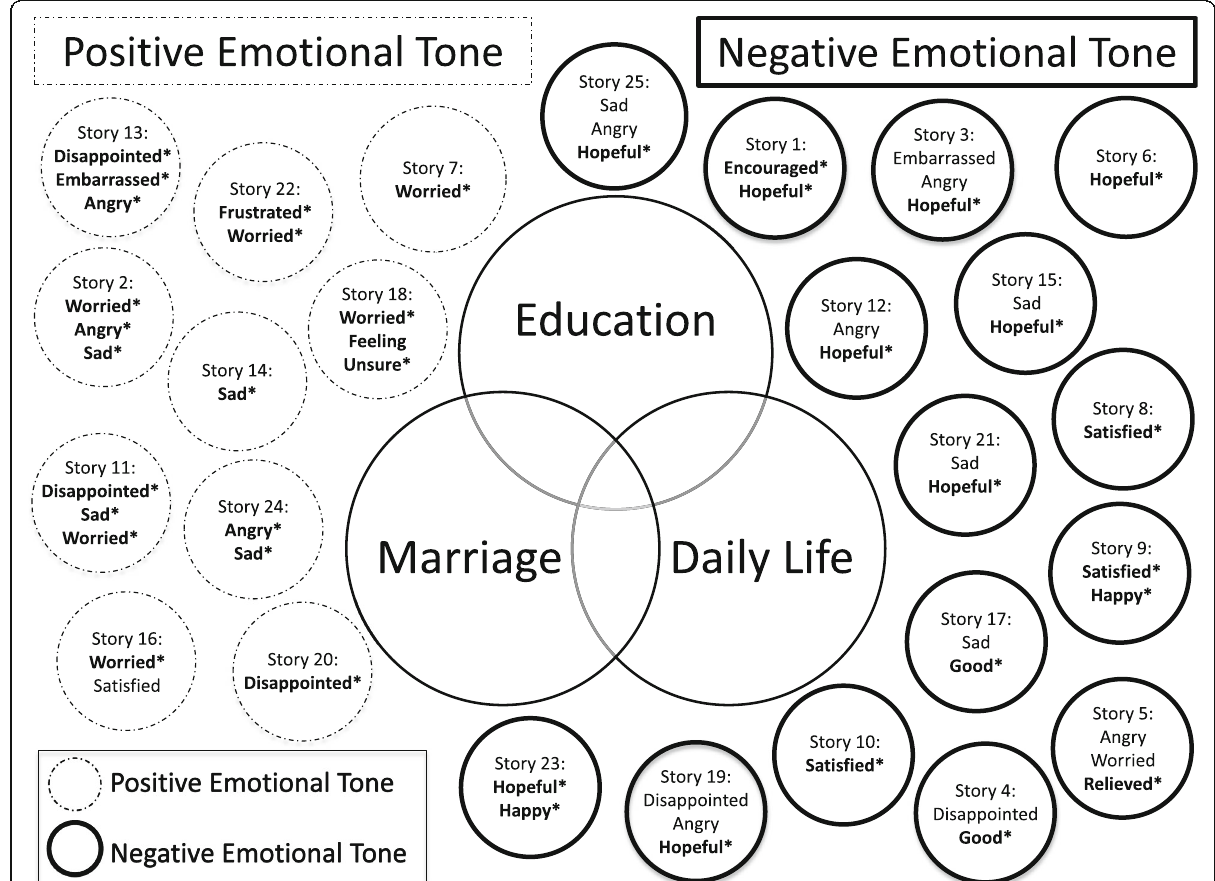
Fig. 1 Overview of all 25 stories displaying the three core categories and the reported emotional tone and feeling(s) attributed to the